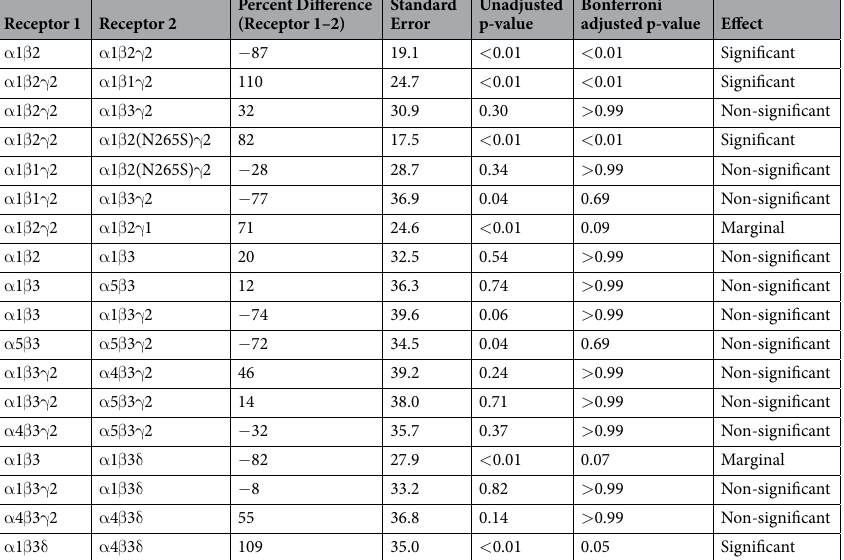
Table 3. Comparison of DCUK-OEt induced changes in EC 10 GABA responses between receptors differing in a single subunit. These comparisons were executed with the linear mixed model using linear contrasts. Correction for multiple pairwise comparisons was by a Bonferroni